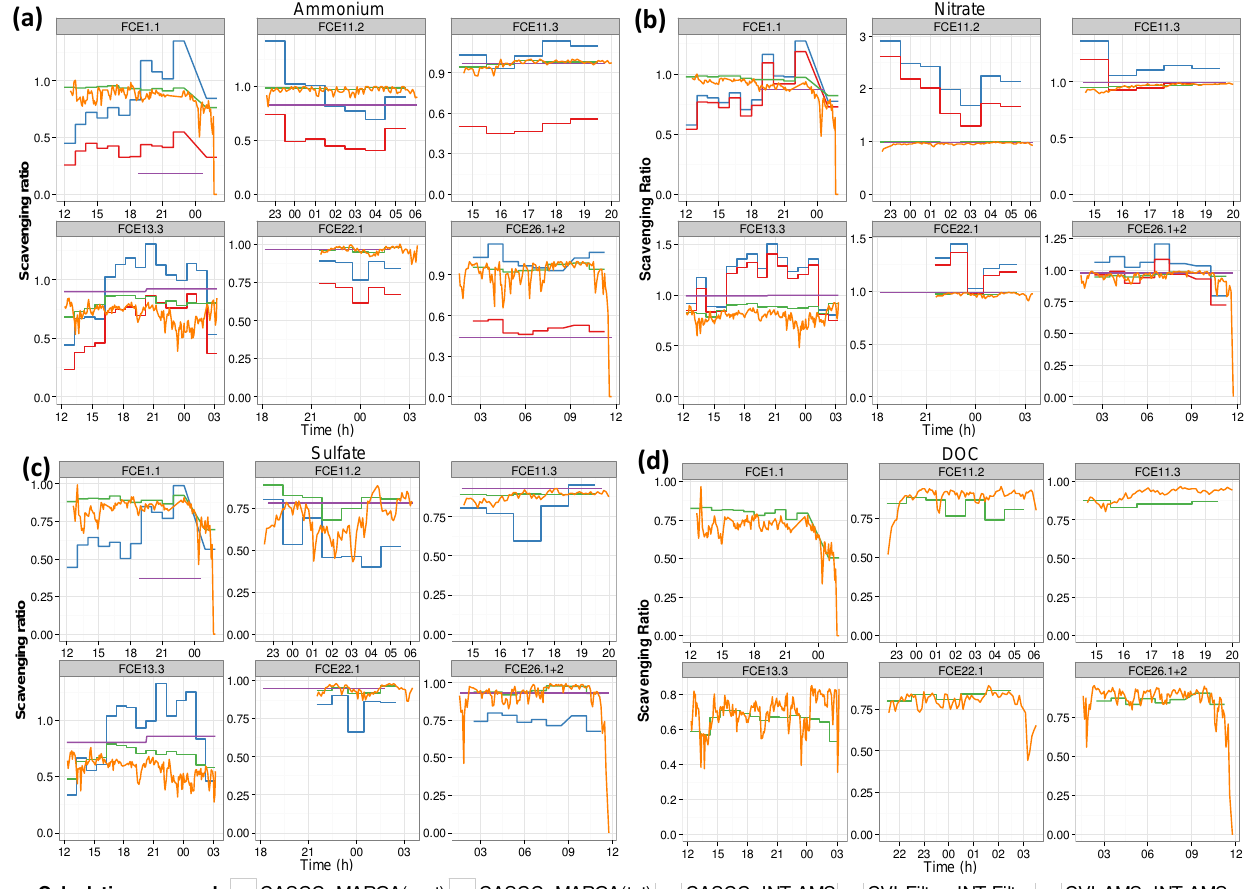
Figure 6. Cloud scavenging efficiencies for (a) ammonium, (b) nitrate, (c) sulfate, and (d) DOC, calculated as “upwind SE” from bulk cloud water loadings and upwind MARGA data (blue and red for MARGA particulate and total aerosol concentrations respectively) and “in-cloud SEs” from bulk CWLs and interstitial AMS data (green), droplet residual and interstitial particle concentrations from filters (purple), and droplet residual and interstitial particle concentrations from AMS (orange). See text for